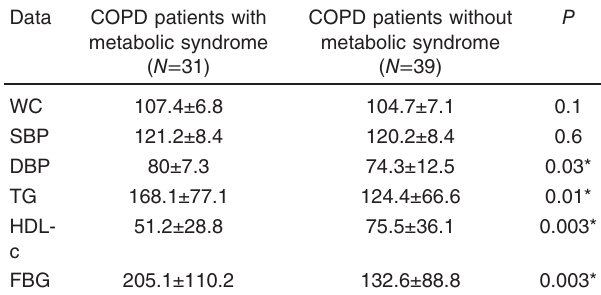
Table 2 Comparison of metabolic syndrome criteria among patients with chronic obstructive pulmonary disease with and without metabolic syndrome Data COPD patients with metabolic syndrome